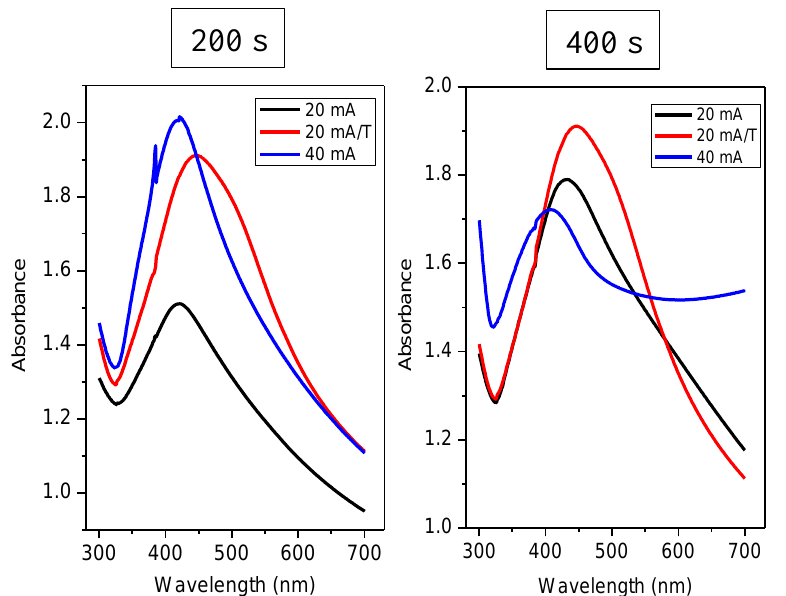
Figure 8. UV-VIS spectrum of Ag layers on PDMS at different deposition times 200 s, 400 s, and current of 20 and 40 mA or samples with the subsequent thermal treatment (20 mA/T).